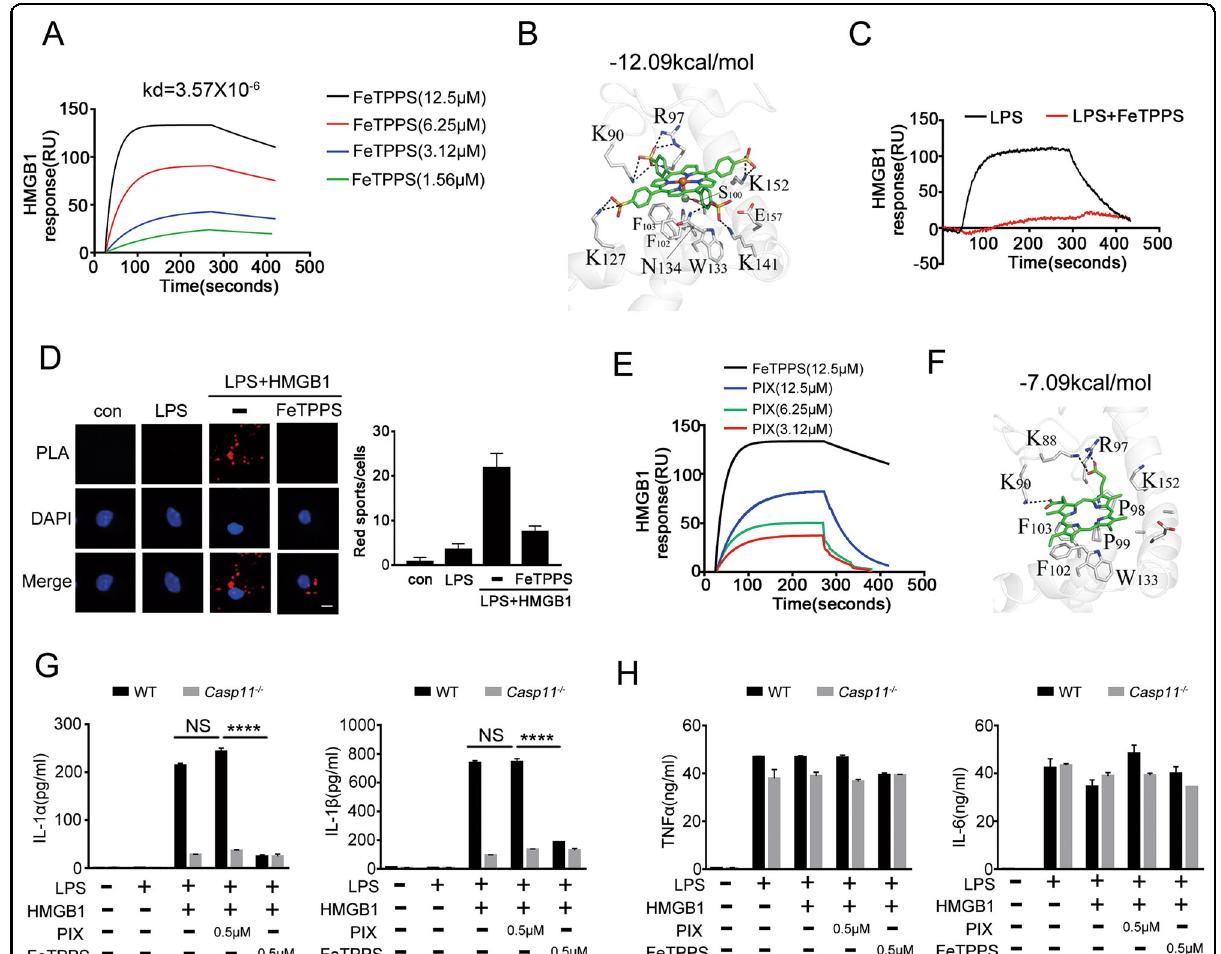
Fig. 5 FeTPPS disrupts the HMGB1-LPS binding. A The sensorgrams of FeTPPS (1.56, 3.12, 6.25, 12.5 μ M) binding to the HMGB1 chip-immobilized proteins are expressed in RU (response unit) vs. time after subtracting the control signal. B The 3D binding model between FeTPPS and HMGB1. The protein is shown as cartoon, the compound is colored in green. High-scoring docking poses of FeTPPS and HMGB1 was − 12.09 kcal/mol. Ionic bonds are shown as dash lines. C The sensorgrams of LPS binding to the HMGB1 chip-immobilized proteins with or without FeTPPS are expressed in RU (response unit) vs. time after subtracting the control signal. D Interaction between HMGB1 and LPS was visualized as red spots under fl uorescence microscopy using the proximity-ligation assay (PLA). Mouse peritoneal macrophages stimulated with LPS alone (5 μ g/mL) or LPS (5 μ g/mL) + HMGB1 (10 μ g/mL) (LH) in the absence or presence of FeTPPS (1 μ M) for 2 h. Scale bar: 10 μ m. E The binding af fi nity of FeTPPS or Protoporphyrin IX (PIX) with recombinant HMGB1 (immobilized) are expressed in RU (response unit) vs. time after subtracting the control signal. F The 3D binding model between PIX and HMGB1. The protein is shown as cartoon, the compound is colored in green. High-scoring docking poses of PIX and HMGB1 was − 7.09 kcal/mol. Ionic bonds are shown as dash lines. G , H Production of IL-1 α , IL-1 β , TNF α and IL-6 (as measured by ELISA) from WT or Casp11 − / − peritoneal macrophages stimulated with LPS (1 μ g/mL) + HMGB1 (400ng/mL) in the absence or presence of PIX or FeTPPS for 16 h. Data presented as mean ± SD of technical replicates. An unpaired t -test (two-sided) was used. **** P < 0.0001. Graphs are representative of at least three independent